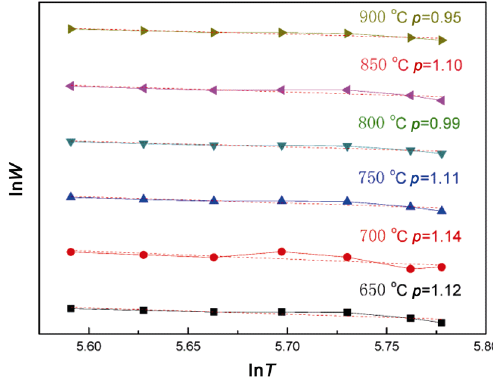
Fig. 8 R 25 and B values of MCNO thin films at different annealing temperatures. Fig. 9 ln W –ln T of MCNO thin films at different annealing